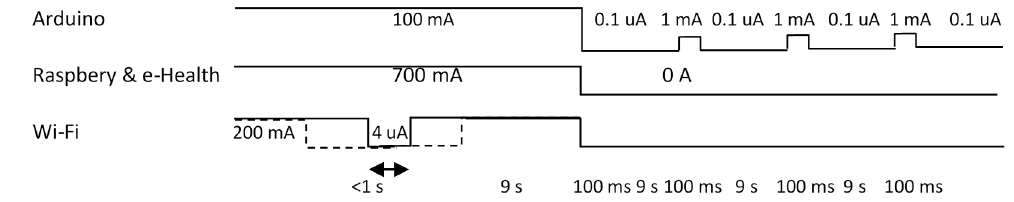
Figure 6. Power Consumption during normal operation and sleep modes.